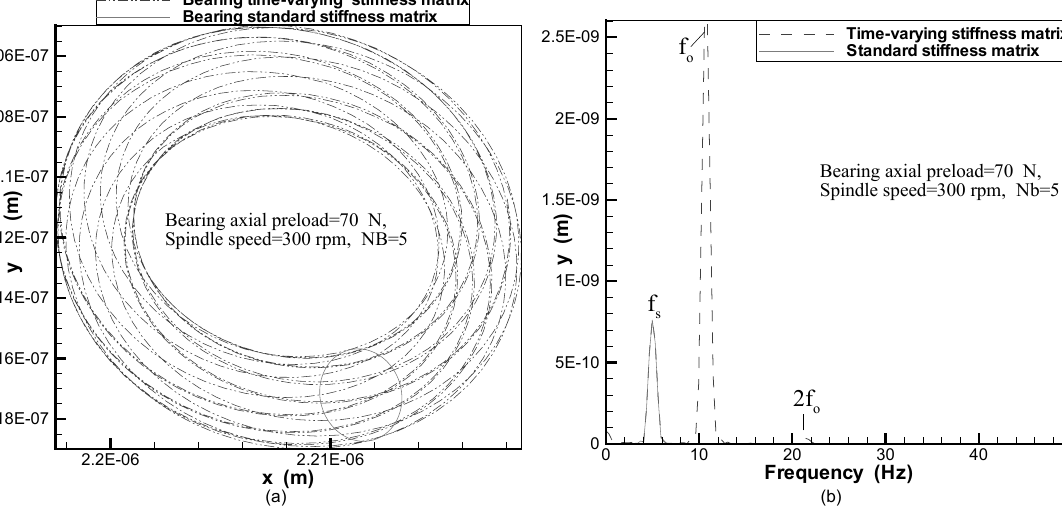
Fig. 9. (a): Gravity center orbit for time-varying stiffness matrix (dash-dot-dot line) and standard stiffness matrix (solid line). external force = 203 N force acting in vertical plane at gravity center and is inclined at 9.87 deg to the positive X s . Ω s = 300 rpm. mass unbalance eccentricity = μ = 18 μm . bearing number of balls Nb = 5, bearing axial preload = 70 N. (b): FFT of y (vertical) vibration of orbit in (a) for μ a b time-varying stiffness matrix (dashed line) and standard stiffness matrix (solid line). horizontal plane acting at the mass center. (this force could be due to a belt tension force, for example). The